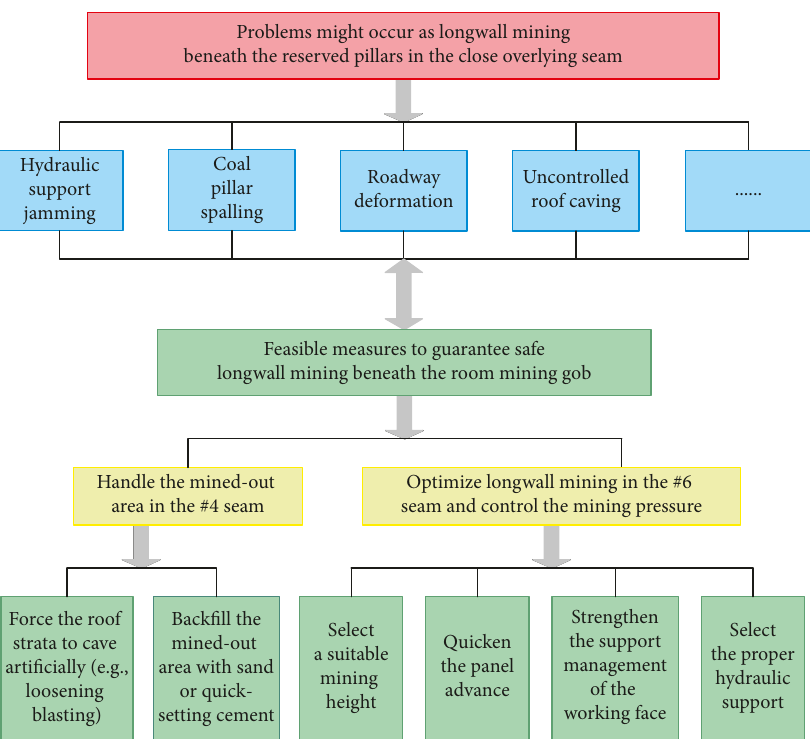
Figure 15: Block diagram of proposed measures to guarantee safe longwall mining beneath room mining